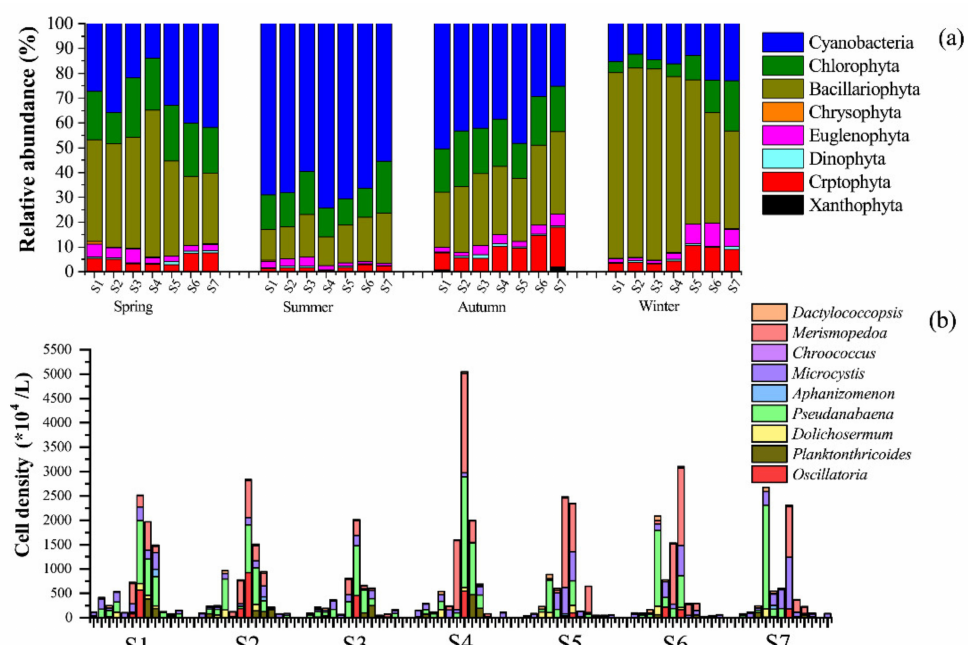
Figure 3. ( a ) Seasonal variations in relative abundance of different phyla, and ( b ) cell density of nine genera in cyanobacteria (each site contains 12 bars corresponding to 12 months). Note: S1 was at the inlet of the whole reservoir; S2 was at the outflow of zone I; S3 was at the outflow of zone II; S4 was at the outflow of zone III, and S5, S6, and S7 were at the inlet, center, and outlet of zone IV, respectively. At S1, Pseudanabaena sp., among five filamentous cyanobacteria, was dominant mostly in spring, autumn, and winter and codominated with Oscillatoria sp. and Planktothricoides sp. in summer. At S7, Pseudanabaena sp. dominated during spring and winter, and codominated with Oscillatoria sp. in summer. It was noted that Planktothricoides sp. dominated in